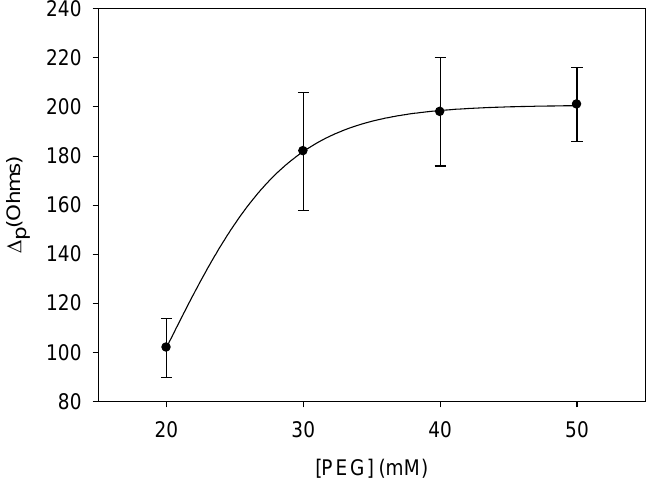
Figure 4. Optimization of the concentration of the blocking agent, PEG. Uncertainty values corresponding to replicated experiments (n =